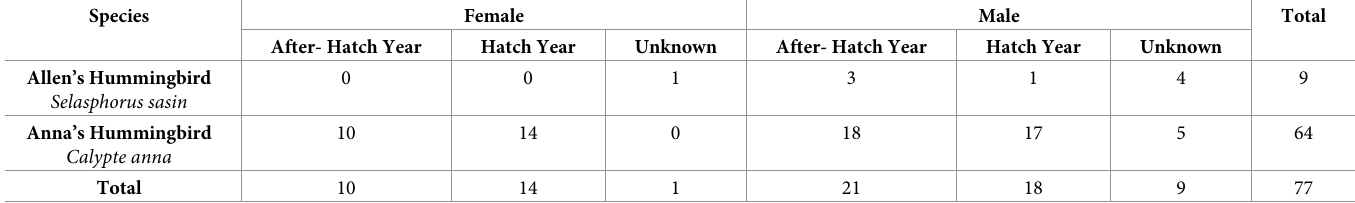
Table 5. The age classes of hummingbirds (n = 77 birds) interacting at feeders at Site 1 and Site 2 in Northern California and Site 3 in Southern between September 2016 –March 2018. Species Female Male Total After- Hatch Year Hatch Year Unknown After- Hatch Year Hatch Year